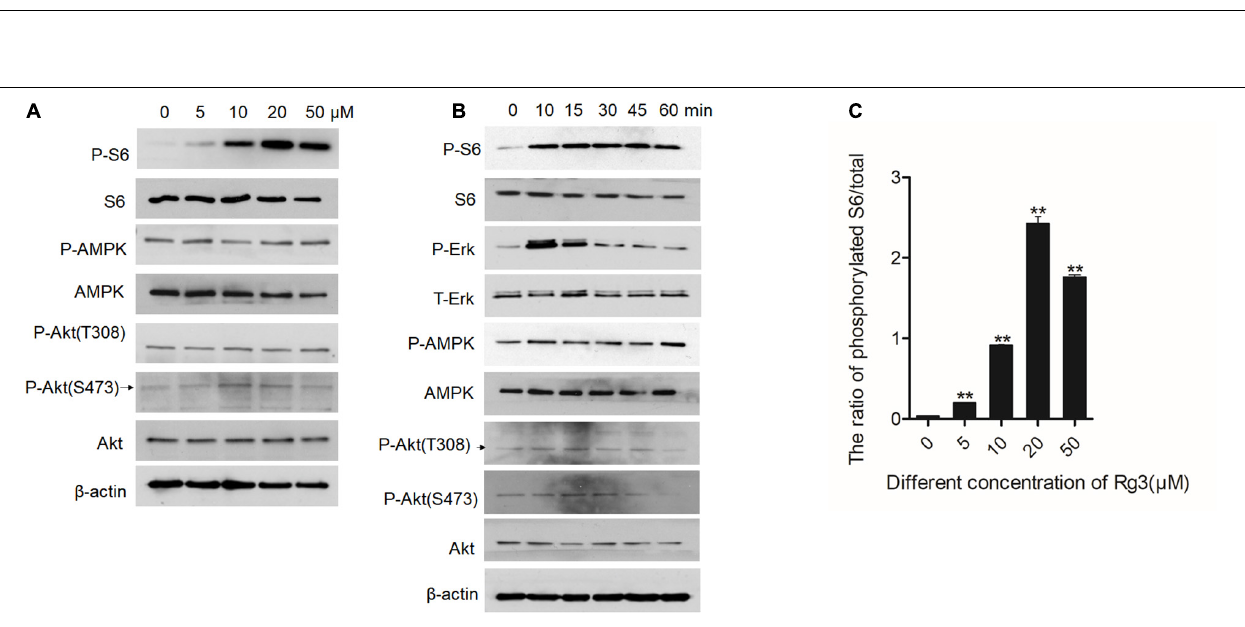
Frontiers in Cell and Developmental Biology | www.frontiersin.org